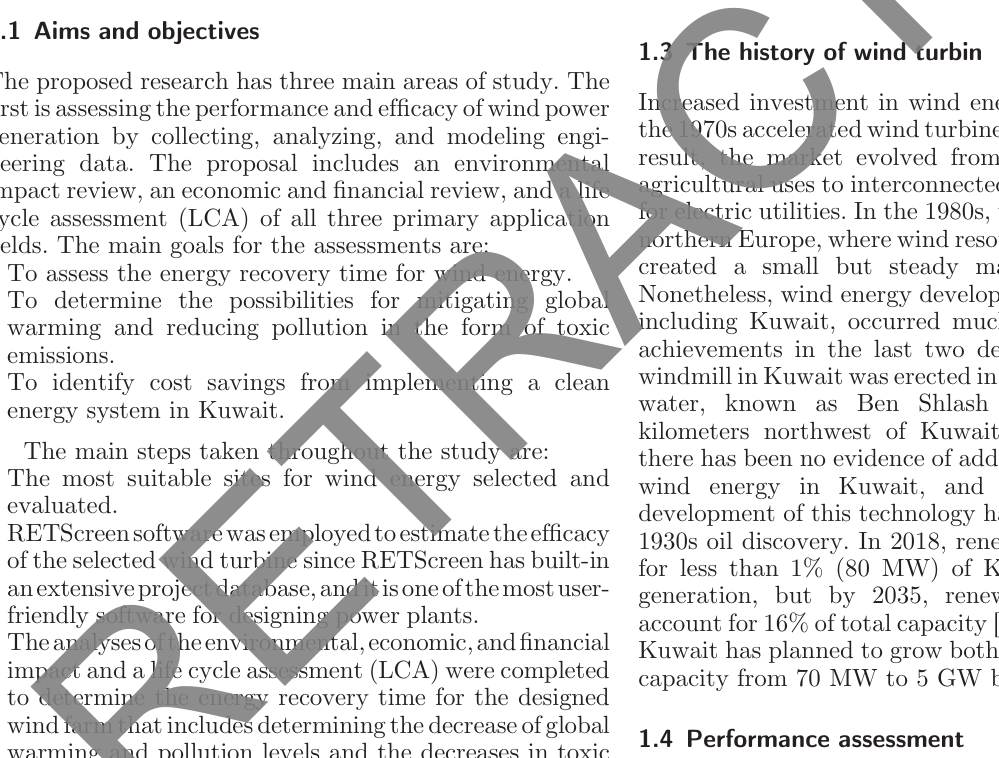
Fig. 1. Accumulative global capacity of installed wind